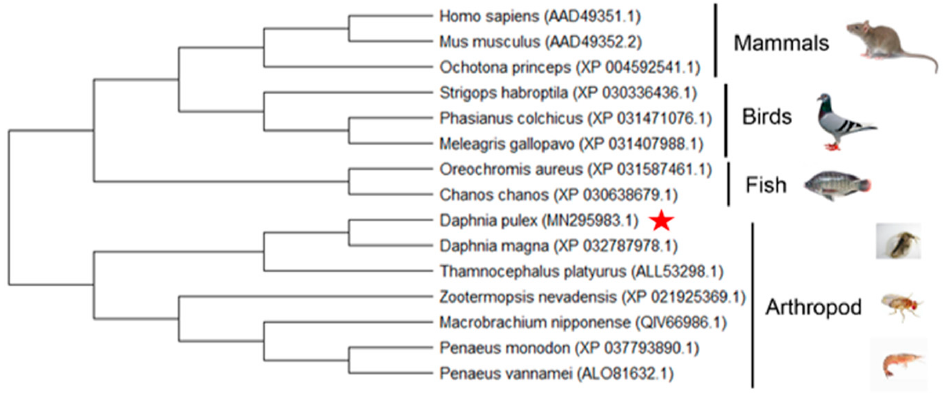
Figure 6. Phylogenetic tree of the Wnt16 clans from multiple species. Phylogenetic trees were constructed by the neighbour-joining (NJ) method using MEGA 5.0 software [30]. Red pentagram: it is Daphnia pluex (MN295982.1).